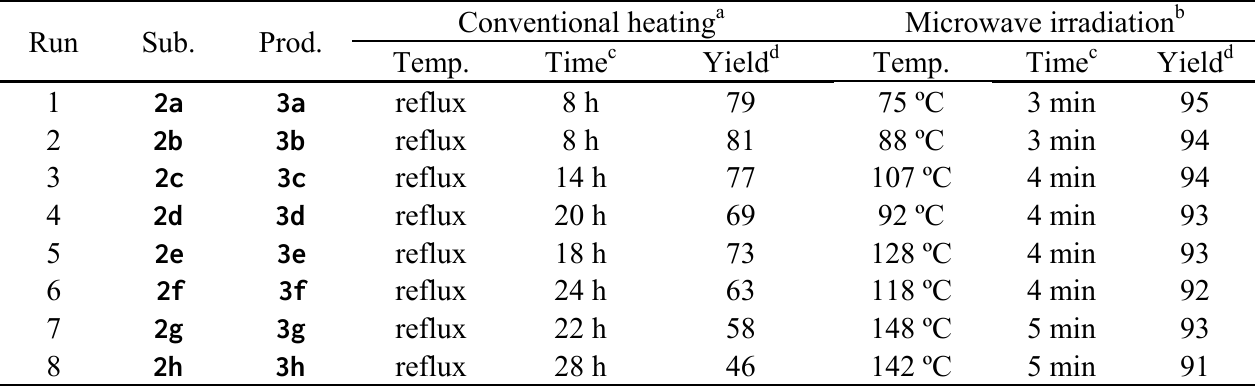
Table 5. Synthesis of alkyl ferulates under conventional heating and microwave irradiation. Run Sub.